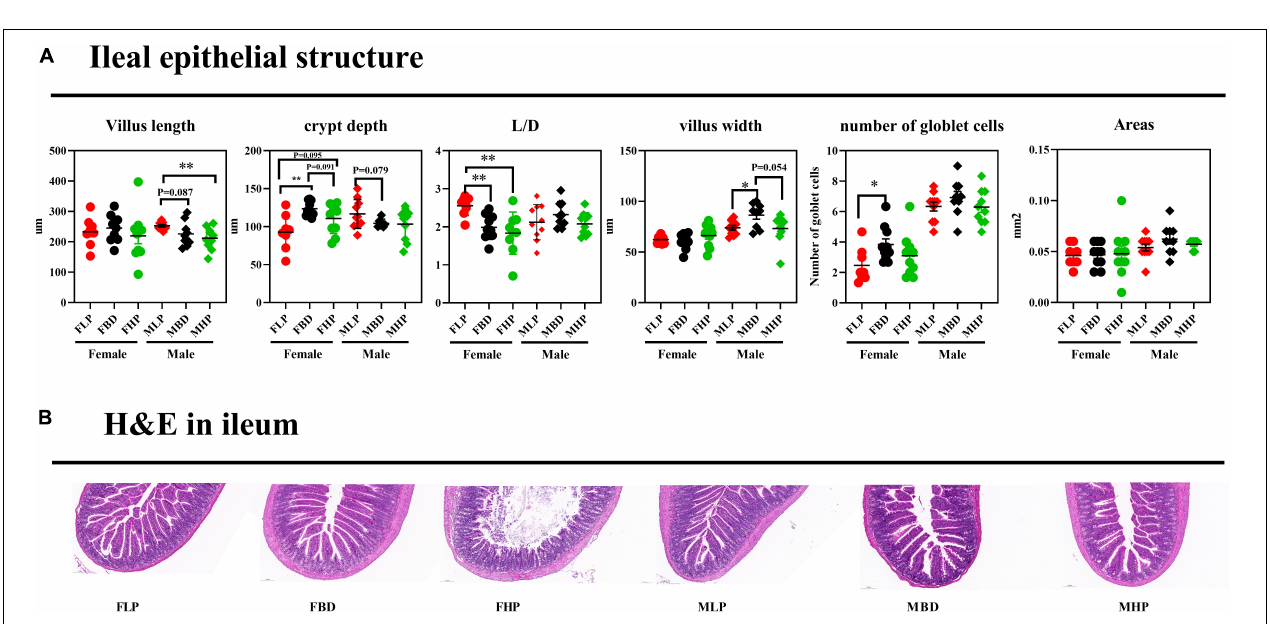
FIGURE 4 | Effects of diets with different protein levels on the morphology of ileal epithelial tissue in mice. (A) The structure of the ileal epithelial tissue. (B) Light microscopy cross-section of ileal